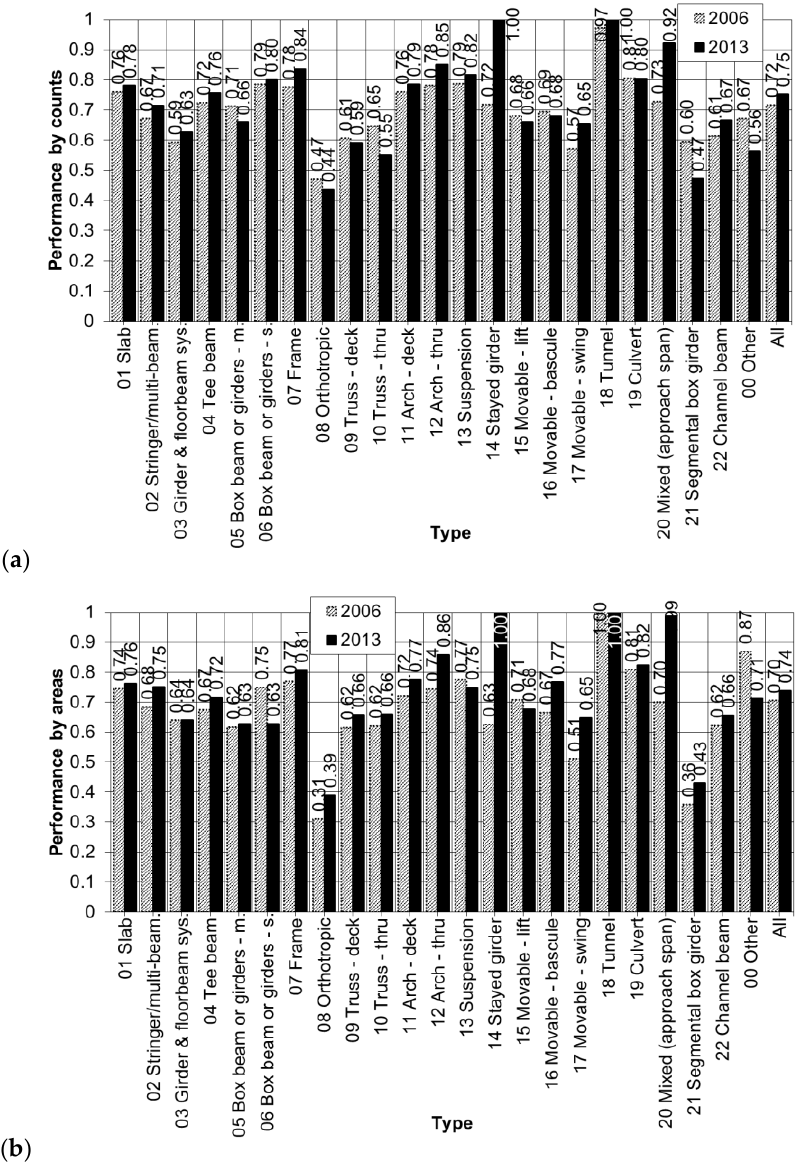
Figure 15. Comparison of structural performances with the year 2006. (a) Counts and (b) Areas.